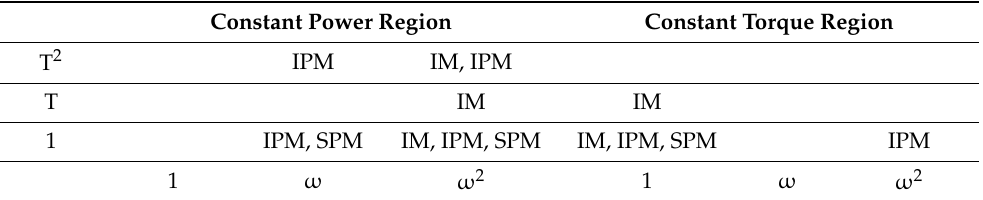
Table 3. The dependency of the machine core loss on the torque and speed of the machine rendering an approximation of the loss in different operating points for each type of the machine [21].